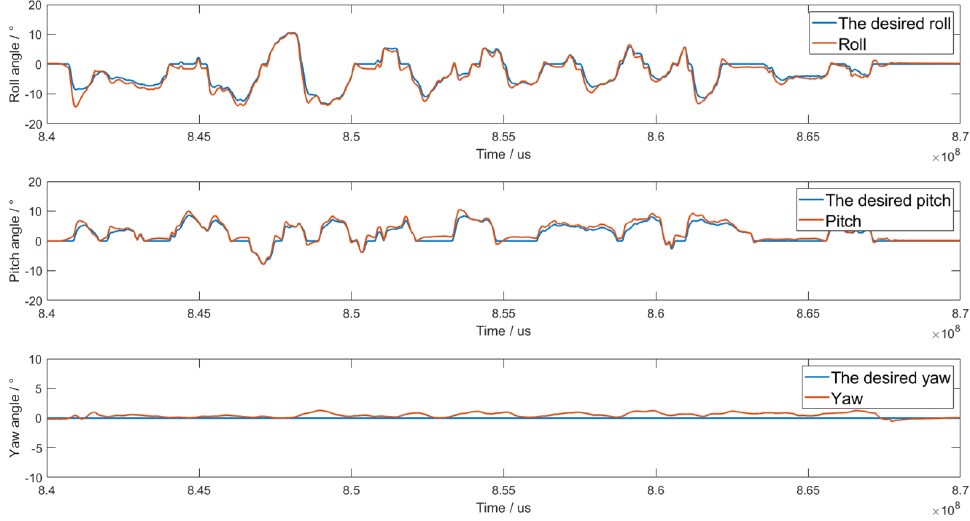
Figure 15. Attitude tracking performance without water in the